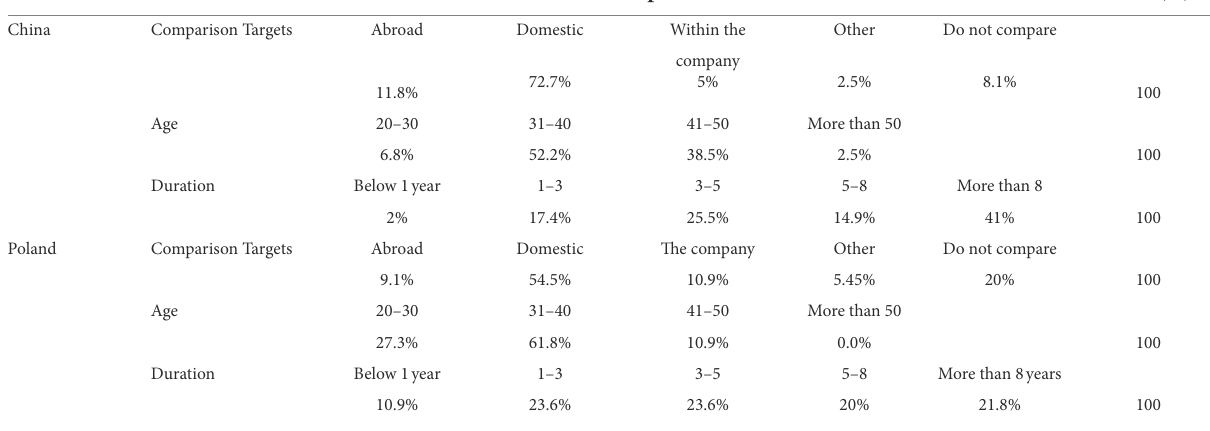
TABLE 1 Basic characteristics of the